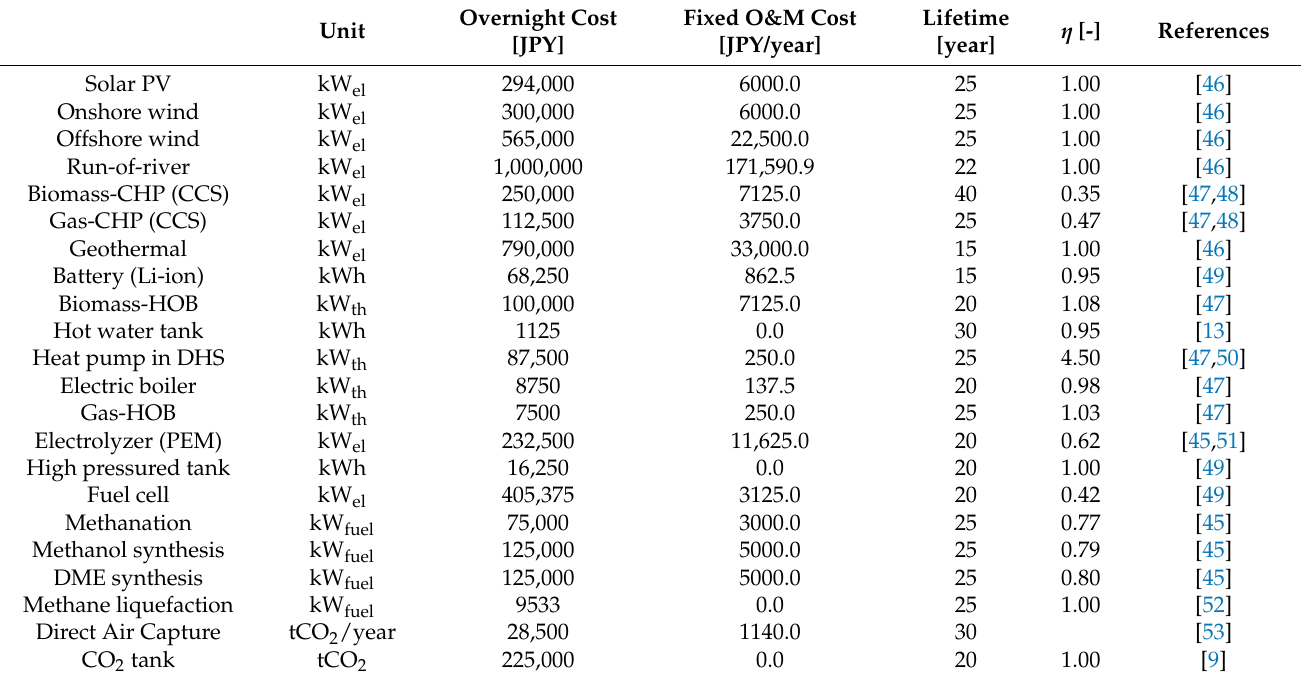
Table 2. Technical and economic parameters in the optimization model.